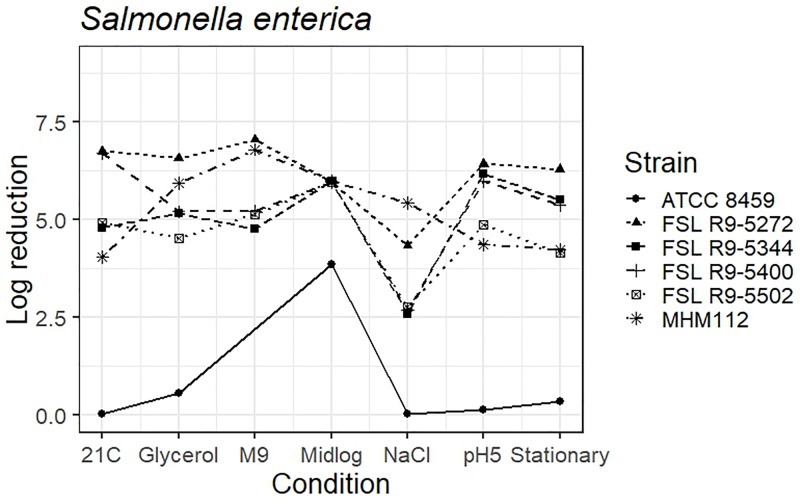
Average log reduction of four S. enterica strains and two surrogate strains (avirulent Salmonella, MHM112 and E. faecium, ATCC8459) when pre-grown under different conditions prior to exposure to 40 ppm PAA for 45 s. Pre-growth conditions are shown on the X-axis and include pre-growth (i) at 21°C (21C), (ii) under reduced water activity (Glycerol), (iii) in minimal medium (M9), (iv) to mid-log phase (Midlog), (v) in 4.5% additional NaCl (NaCl), (vi) at pH 5.0 (pH5) and (vii) to stationary phase (Stationary). When calculating log reduction, values with count zero post-sanitizer treatment were substituted with the detection limit (e.g., 100 CFU/mL). Data represent averages from three trials; the standard deviation of the three trials and number of trials with values below detection limit after PAA exposure are listed in Supplementary Table 6.